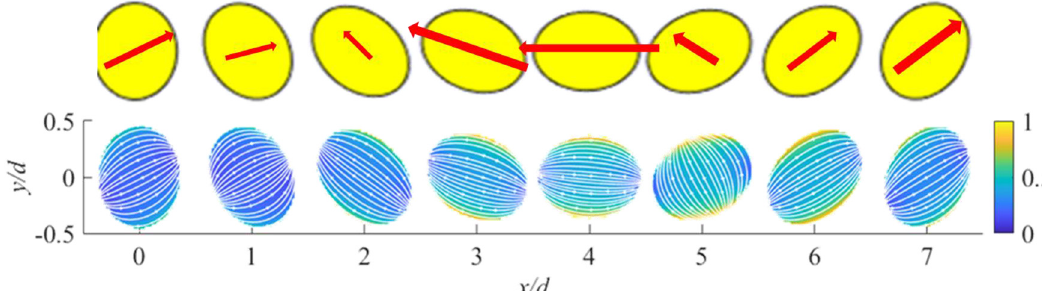
Fig. 9. Real part of the vector currents across a period of a modulated MTS. Top line: currents provided by the PIBC model sampled at the center of the single unit cells. Bottom line: currents on patches provided by the spectral MoM with entire domain basis